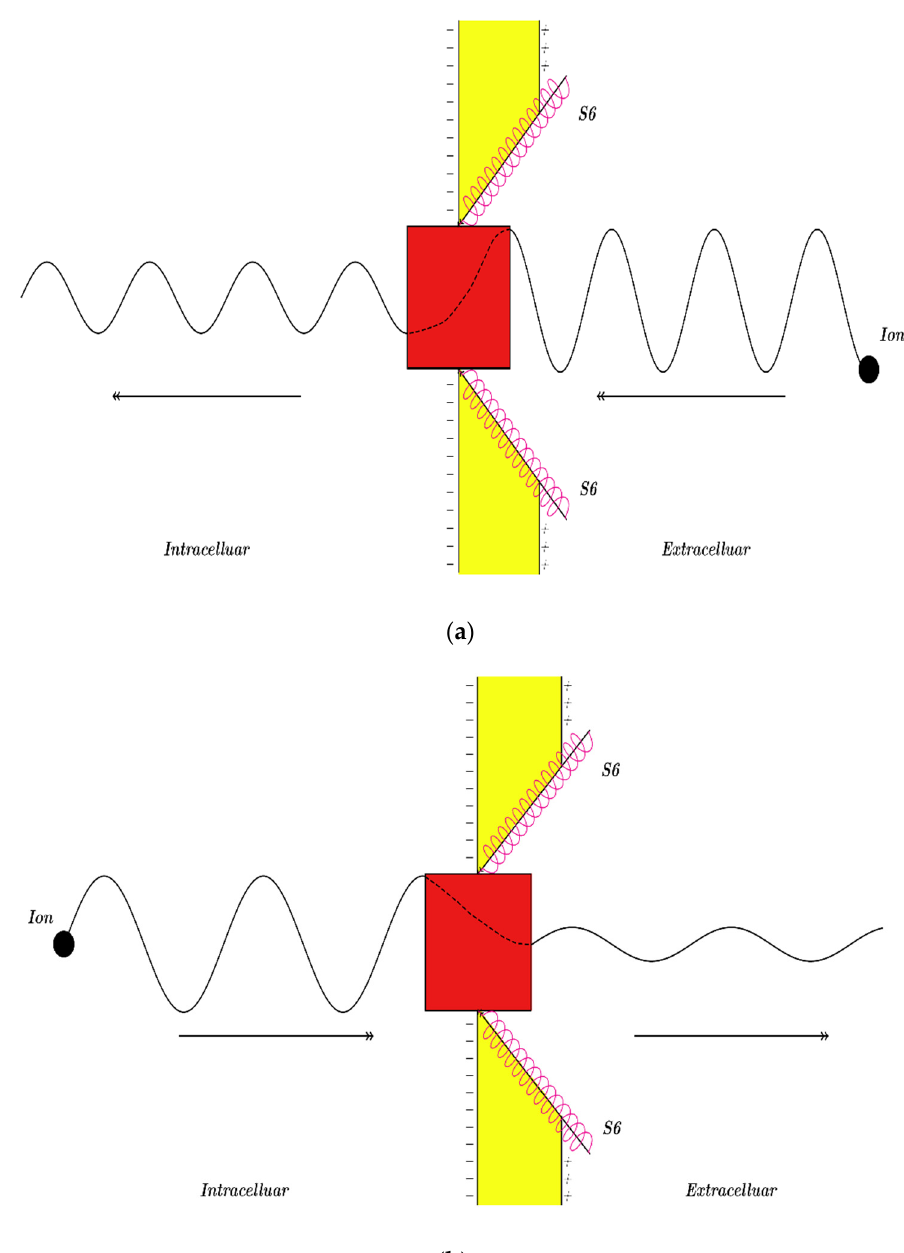
Figure 35. A schematic diagram represents the quantum wave behavior of an ion and the quantum tunneling through the intracellular gate (shown in red) indicated by the dashed line in the gate, which is formed by the crossing of the four S6 segments near the intracellular side (two of them are shown for simplicity). Figure ( a ) represents quantum tunneling of an ion moving from the extracellular side to the intracellular side. Figure ( b ) represents quantum tunneling of an ion moving from the intracellular side to the extracellular side. Notice that the extracellular ion, as in Figure ( a ), has shorter wavelength (the distance from peak to peak) when it is compared with that of the intracellular ion, as in Figure ( b ). This indicates that extracellular ions have higher kinetic energy since it is inversely correlated with the wavelength. Additionally, the wave amplitude of the extracellular ion passing after the gate, as in Figure ( a ), is higher than that of the intracellular ion, as in Figure ( b ). This indicates that extracellular ions have higher tunneling probability since it is proportional to the wave amplitude.